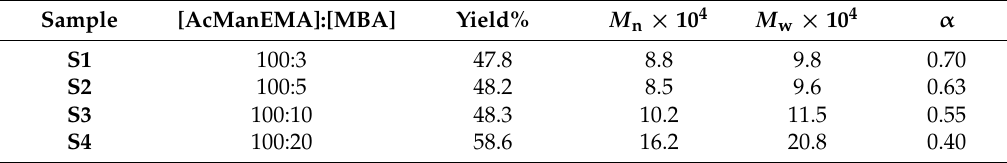
Table 1. The effect of feed ratio of AcManEMA and MBA on the structure parameters. a,b. Sample